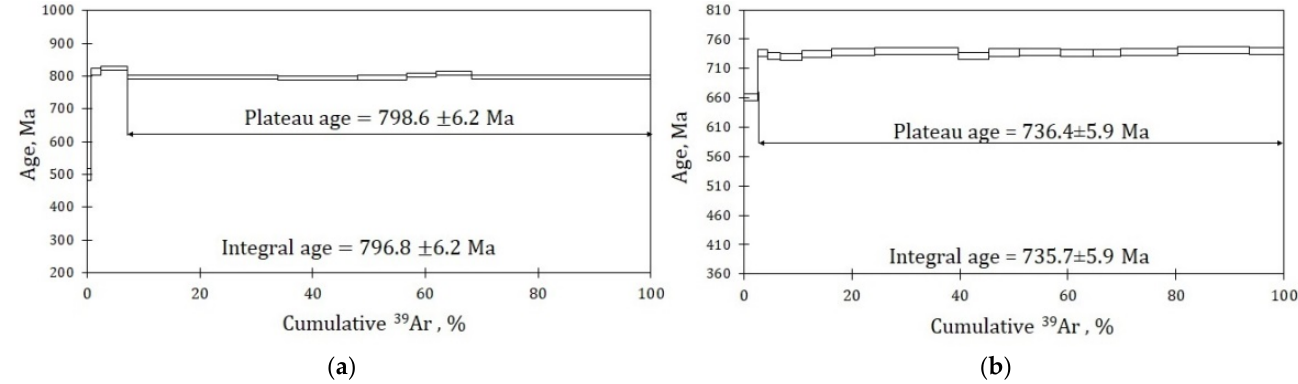
Figure 6. 40 Ar/ 39 Ar age spectra of muscovites from schists of the ore field of the Blagodatnoye deposit: ( a )—113–31; ( b )—113–54.